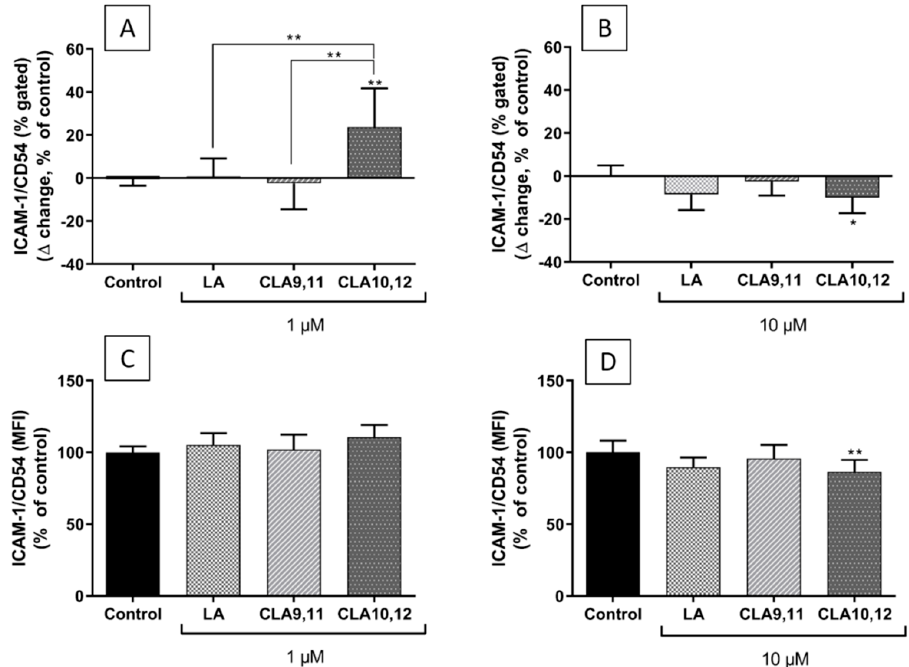
Figure 7 . Cell surface expression of ICAM-1 (also known as CD54) as % of EA.hy926 cells gated ( ∆ change, % of control) ( A and B ) and as median fluorescence intensity (MFI, % of control) ( C and D ) after preincubation for 48 h with DMEM containing 0.1% ethanol (Control) or different concen- trations (1 μ M and 10 μ M) of fatty acid, followed by incubation with tumour necrosis factor α (1 ng/mL) for 6 h. Bars are mean ± SD of 9 samples from 3 experiments. Data were analysed using one-way ANOVA with Tukey’s post hoc test. * p < 0.05; ** p < 0.01; where asterisks are shown im- mediately above a bar they refer to dfference from Control and where asterisks are shown above a horizontal line they refer to differences between the two groups indicated by that line. LA–linoleic acid, CLA9,11– cis -9, trans -11 linoleic acid, CLA10,12– trans -10, cis -12 linoleic acid.